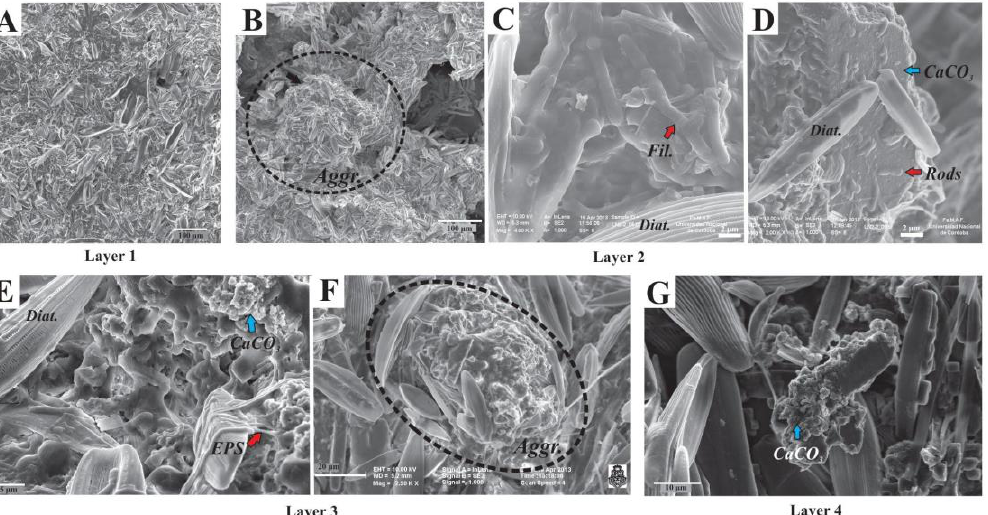
Figure 8. SEM images of the studied microbial mat layers. ( A ) Abundant pennate diatoms (image from Layer 1); ( B ) Irregular-subspherical diatom-microbe-mineral aggregates (image from Layer 2); ( C , D ) Filamentous and rod-shaped microbes within the EPS matrix together with mineral particles; ( E ) Diatoms and microbes immersed within the EPS matrix where clusters of irregular-globular mineral particles are also observed (blue arrow). Note the fibrillar textures of EPS (red arrow); ( F ) Subspherical aggregates where diatoms, EPS, and mineral remains are observed (picture from Layer 3); ( G ) Irregularly shaped mineral cluster where subhedral carbonate mineral particles are observed (image from Layer 4).